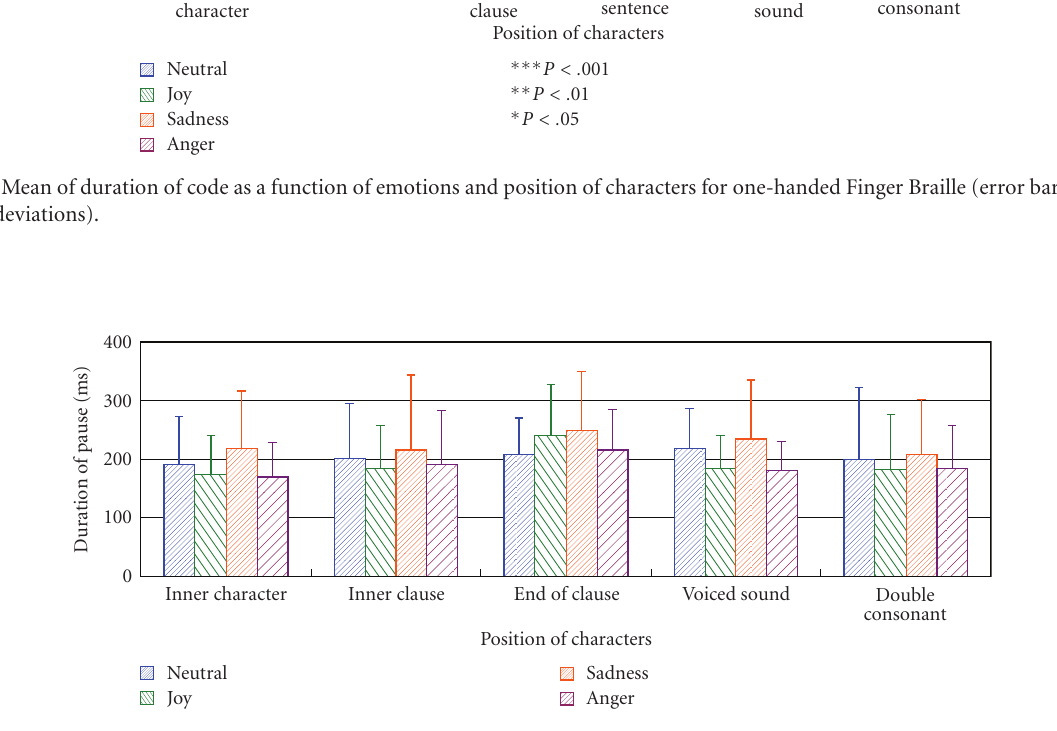
Figure 9: Mean of duration of pause as a function of emotions and position of characters for one-handed Finger Braille (error bars represent standard